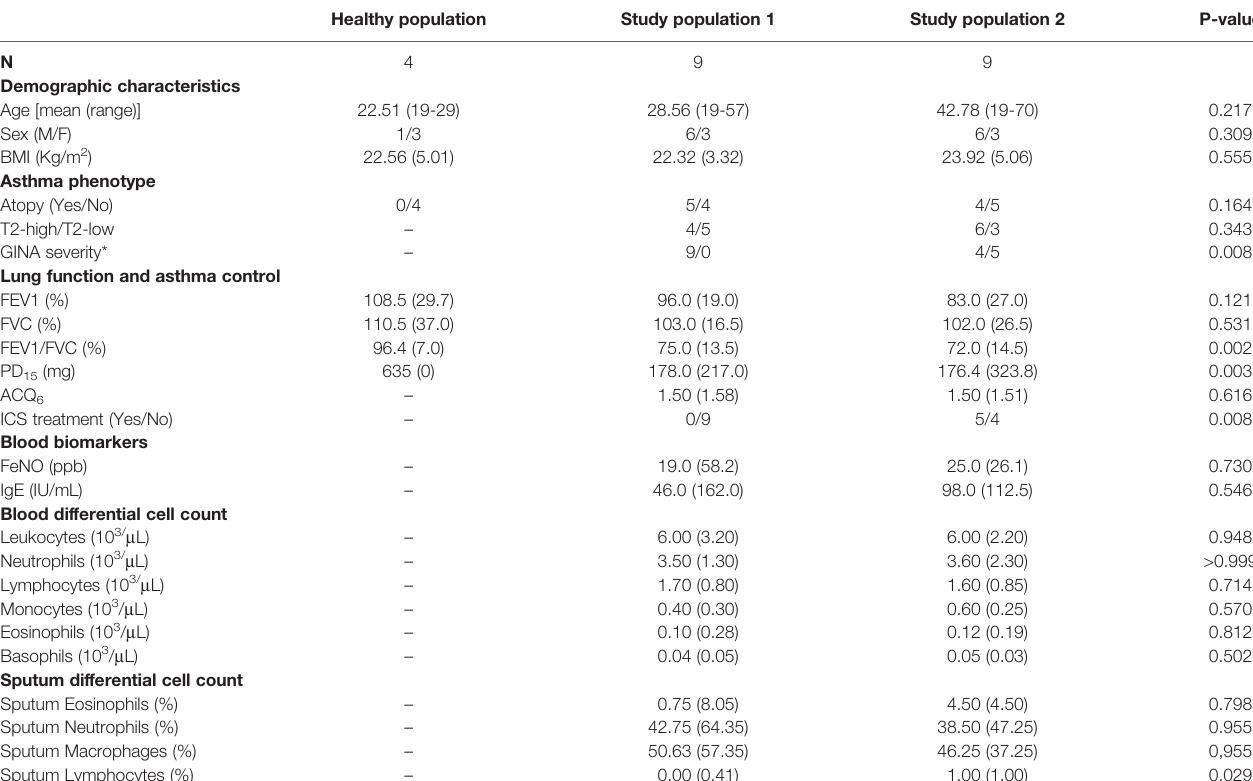
TABLE 1 | Clinical and demographic characteristics of asthma patients. Healthy